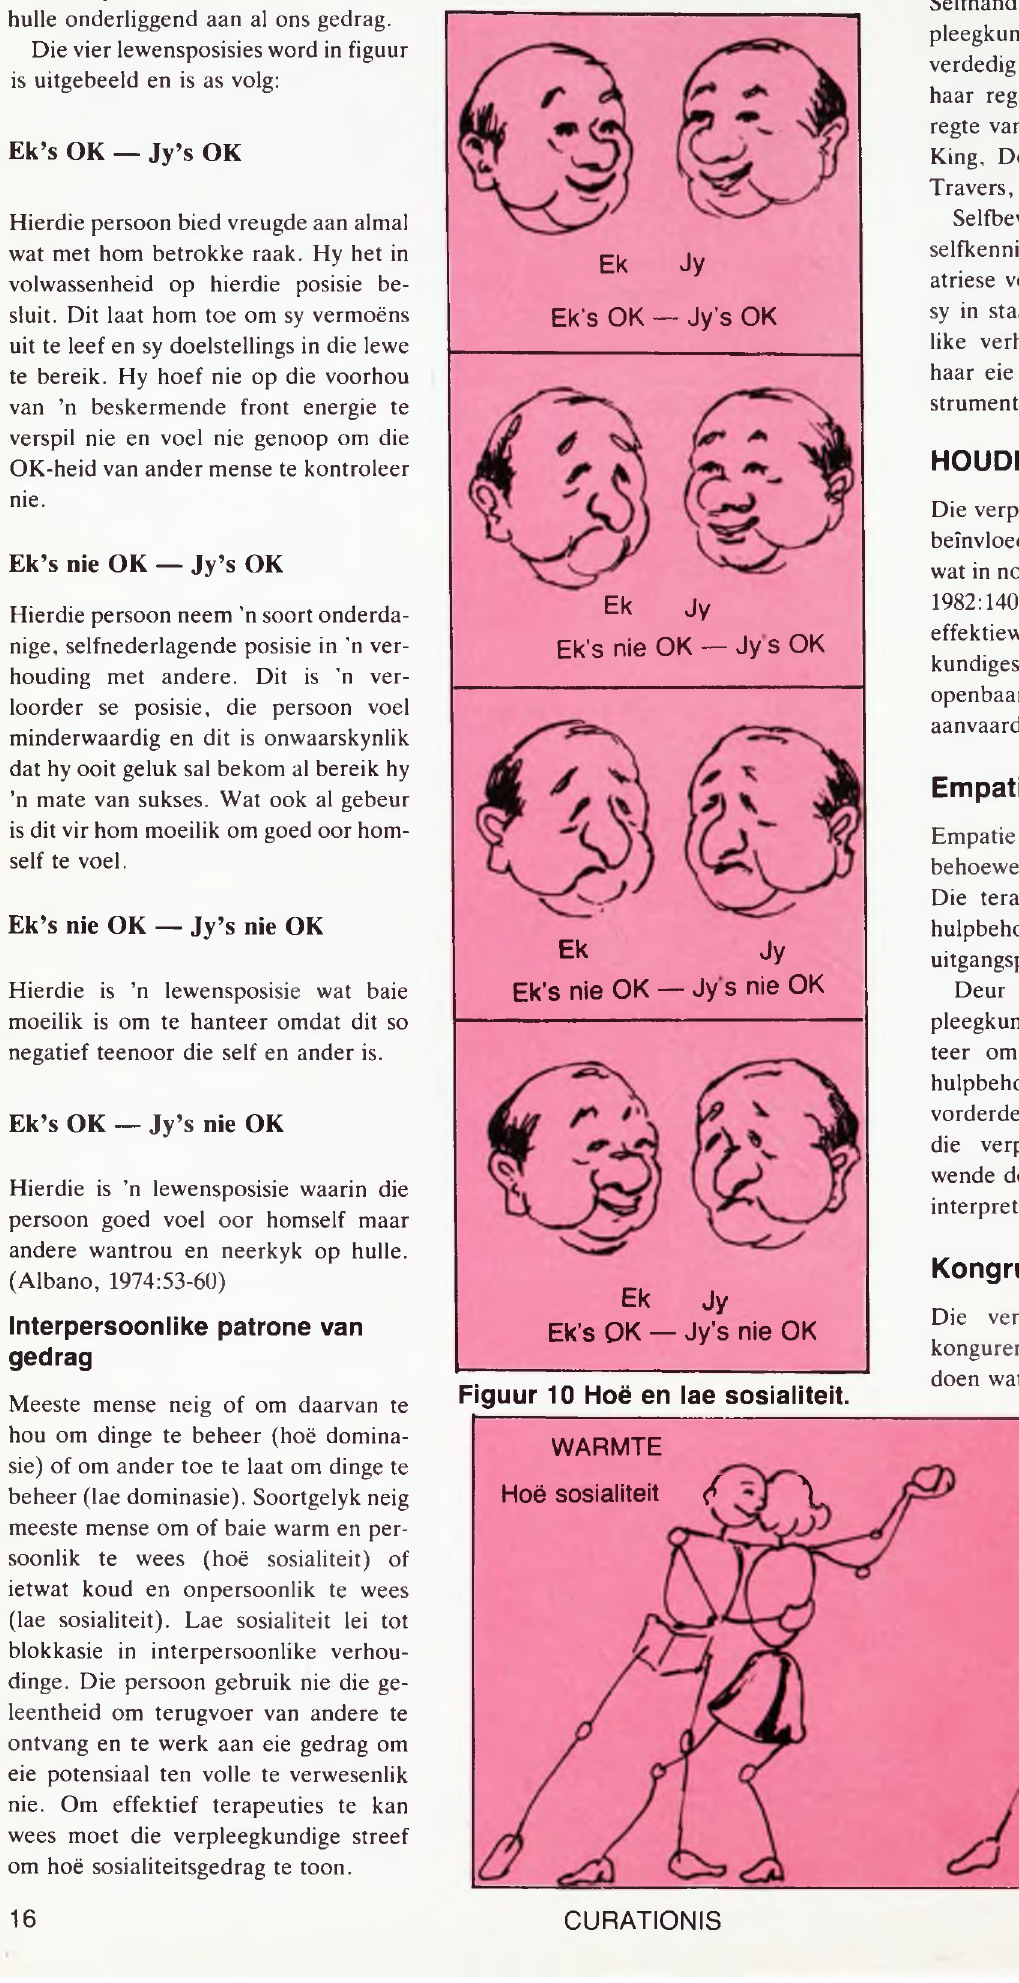
Figuur 9 Die vier lewensposisies